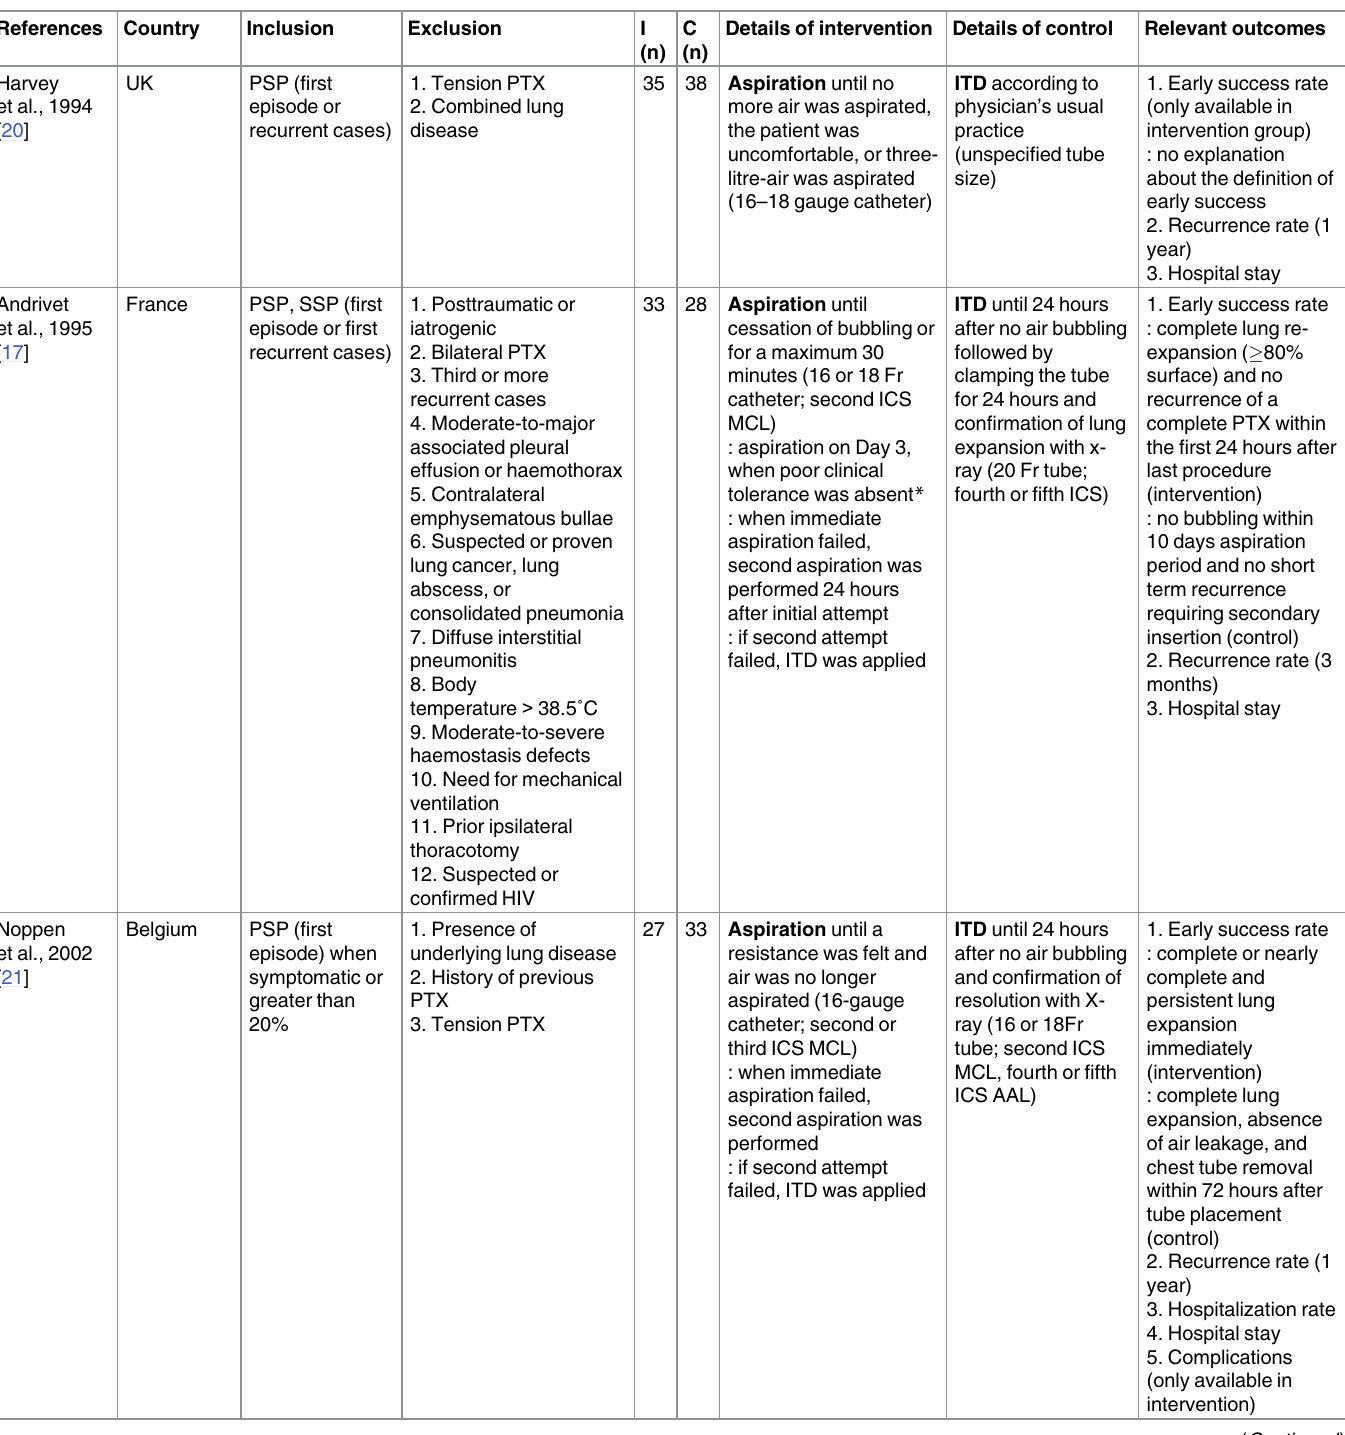
Table 1. Characteristics of included